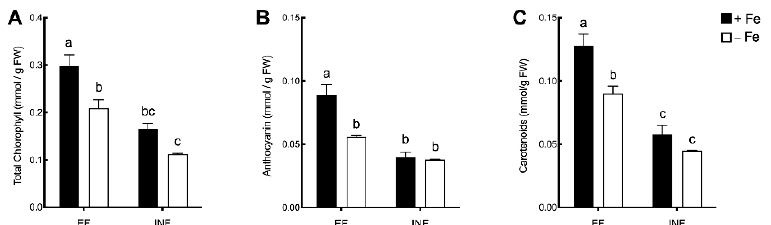
Figure 4. Photosynthetic pigment concentrations (mmol/g FW) in the trifoliate leaves of efficient (EF) and inefficient (INF) soybean lines grown under Fe sufficiency (+Fe, 20 µM) or Fe de fi ciency ( − Fe, no Fe) for 14 days under hydroponic conditions. ( A ) Total chlorophyll; ( B ) anthocyanin; ( C ) carotenoids concentrations. Data are means ± SE; different letters indicate significant differences ( p < 0.05) by ANOVA with Tukey correction test.